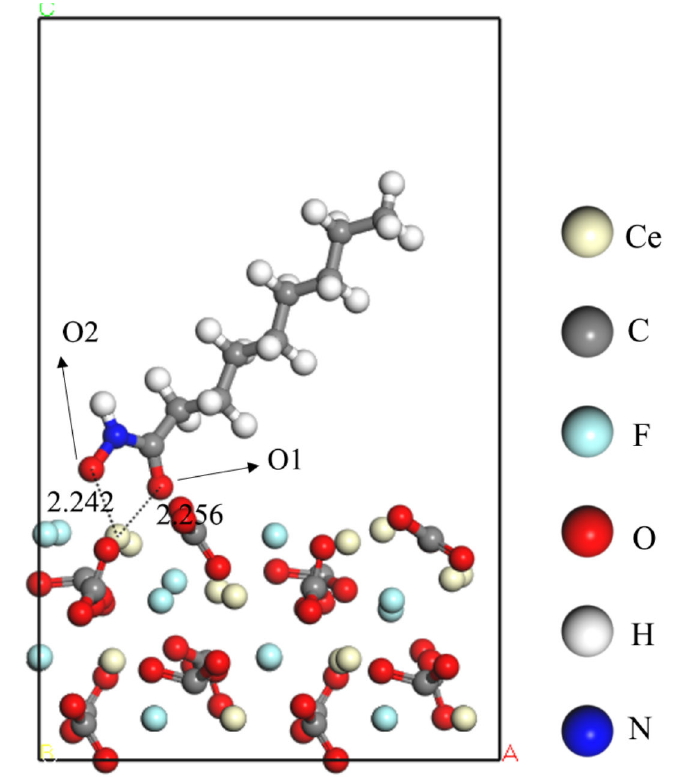
Figure 3. Coordination of NHA via the formation of a five-membered chelate ring with Ce on the (100)